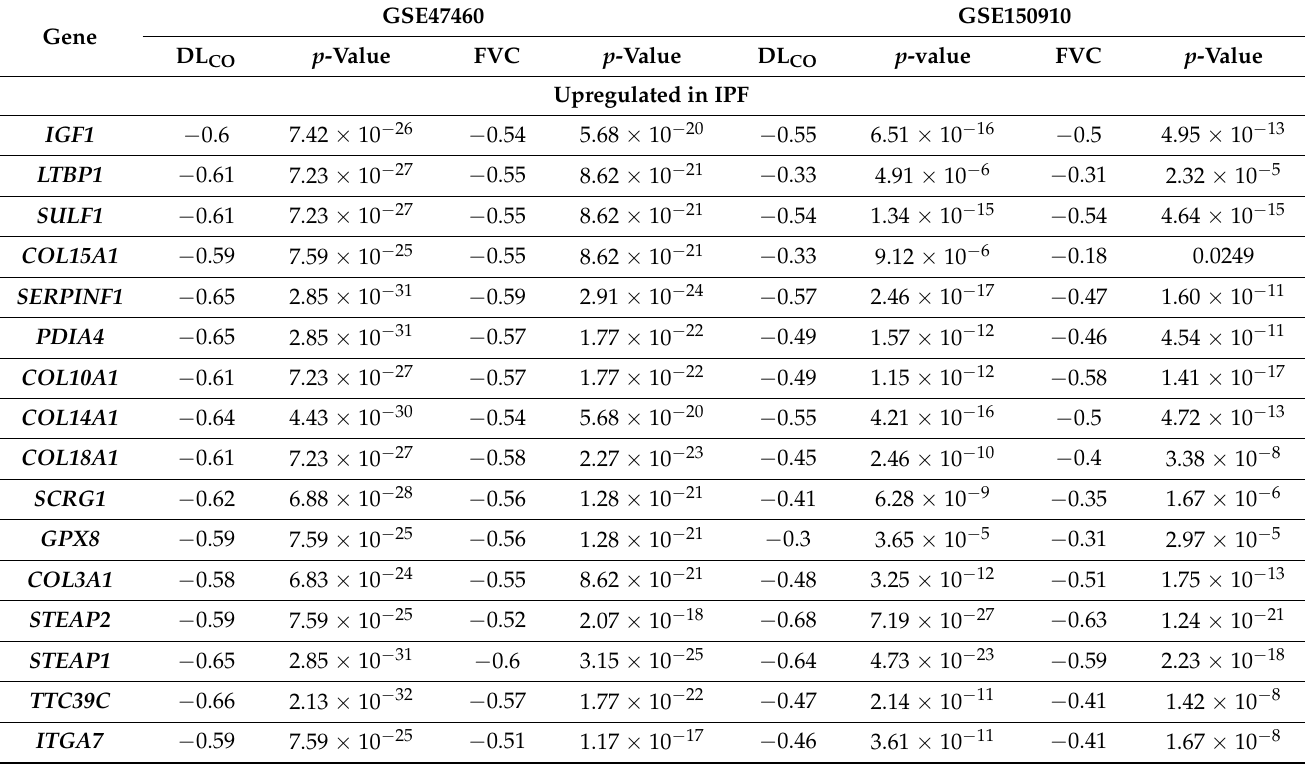
Table 1. List of selected novel candidate genes found to be associated with DL CO and FVC/FEV lung function traits (from Open Targets Genetics portal and GWAS Catalog). Also reported are the correlations computed between the expression levels of the candidate genes and the lung function trait measurements from GSE47460 and GSE150910